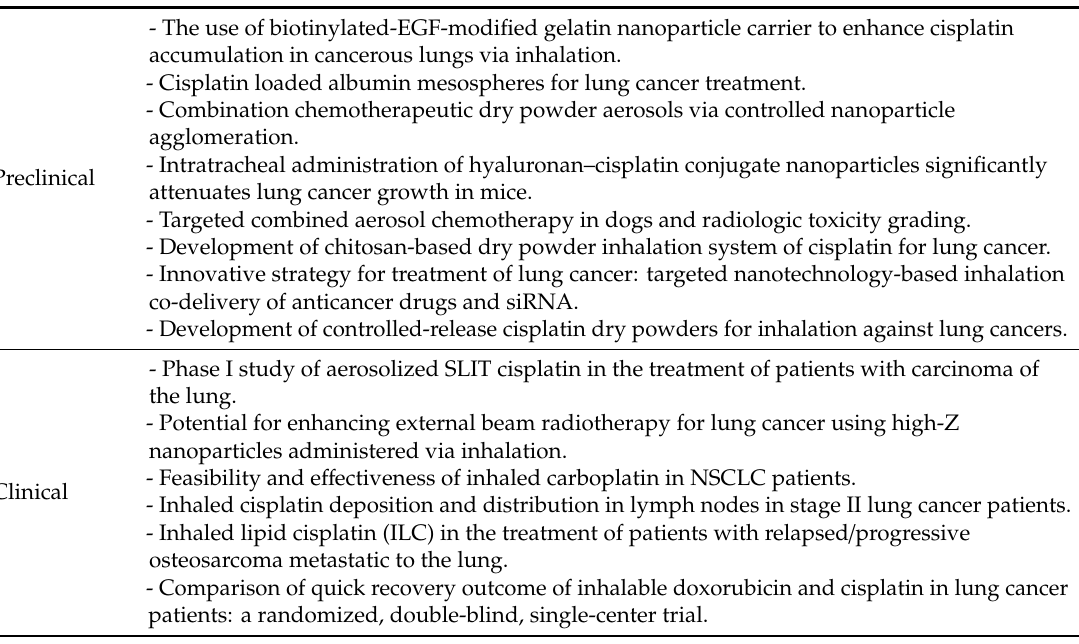
Table 1. Inhalation